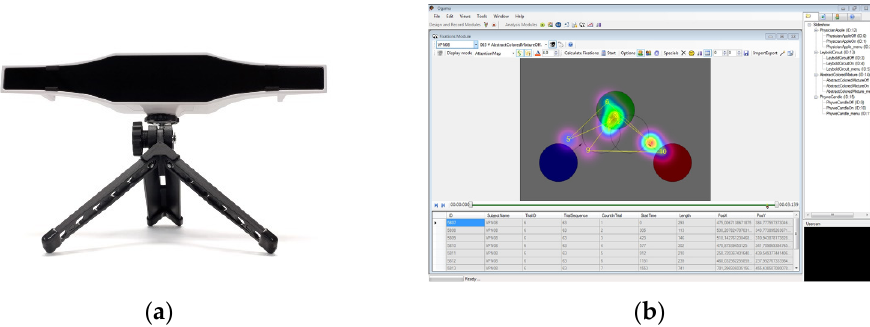
Figure 3. GP3 eye-tracker device; ( a ) and the recording module of OGAMA software package ( b ).